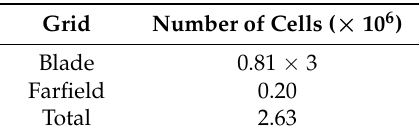
Table 2. Number of cells in each